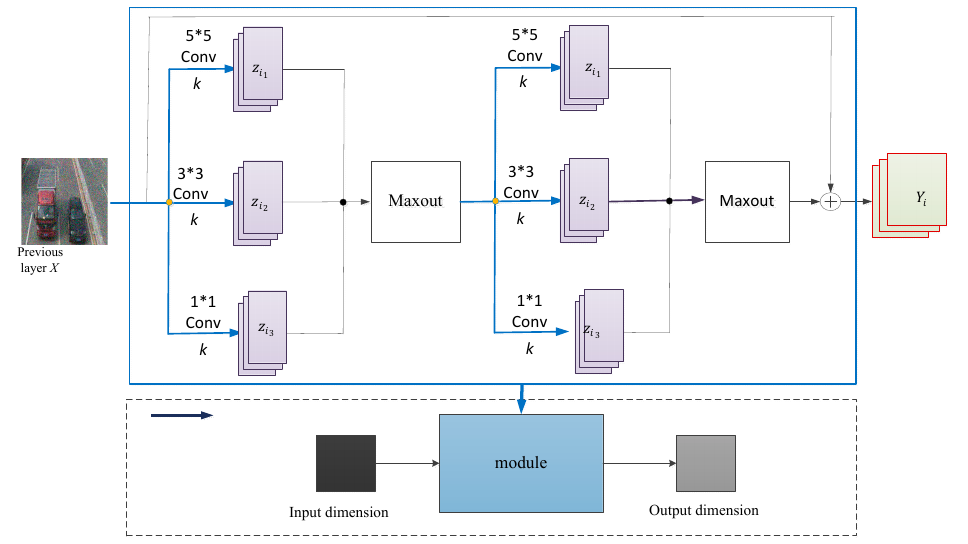
Figure 4. Multi-scale residual learning module.